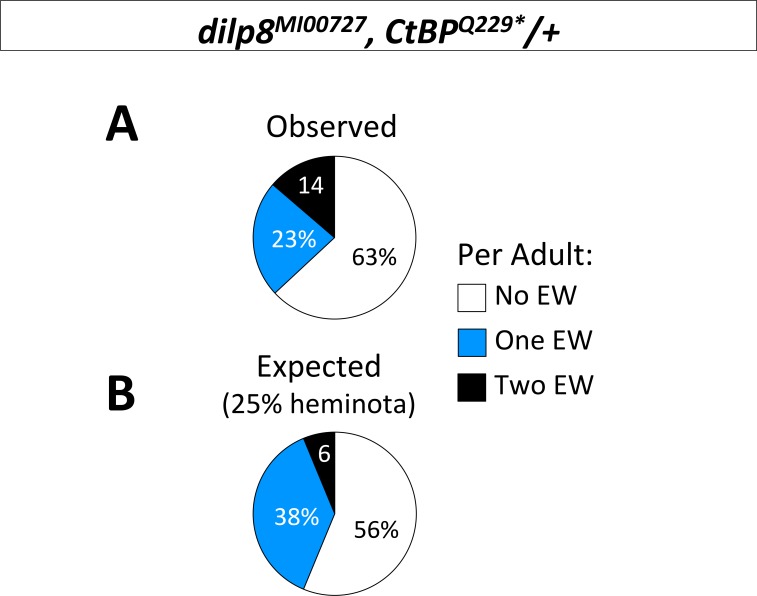
Bilateral ectopic wings slightly more frequent than expected for completely independent events.The observed (A) and expected (B) frequency of dilp8MI00727, CtBPQ229*/+ adults with zero, one or two ectopic wings, following damage and regeneration. The expected frequency is calculated from the observed frequency of ectopic wings per heminotum, assuming that the events in one wing disc are completely independent from the other.